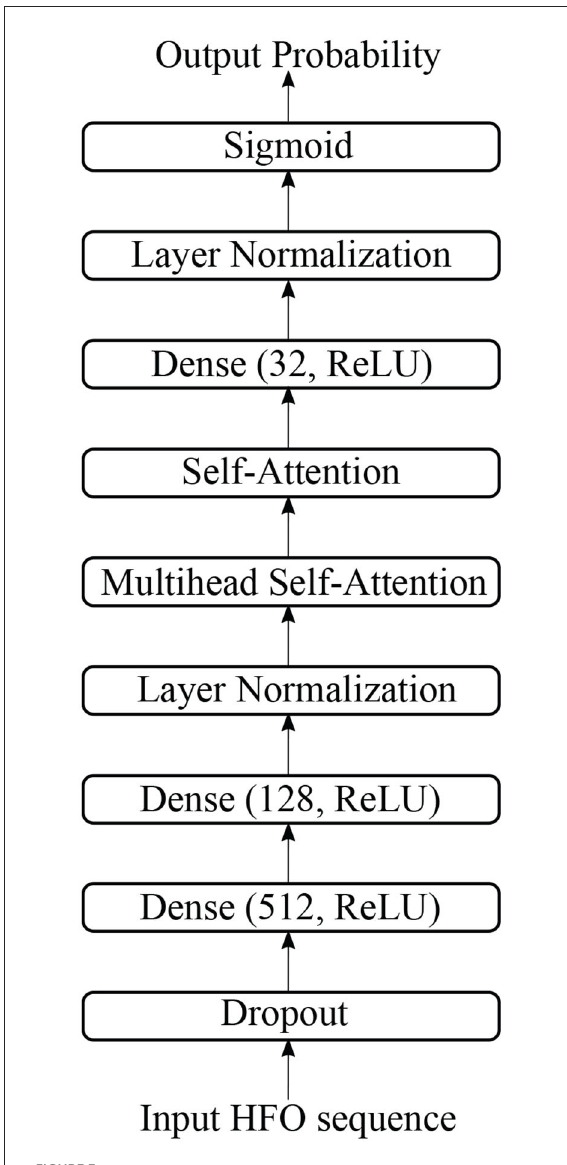
FIGURE3 The structure of multi-head self-attention-based detector in this study.